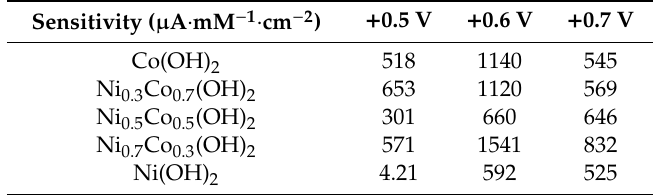
Table 2. Sensitivity of Ni x Co 1-x (OH) 2 / CP at di ff erent electrode potentials (vs. Hg /